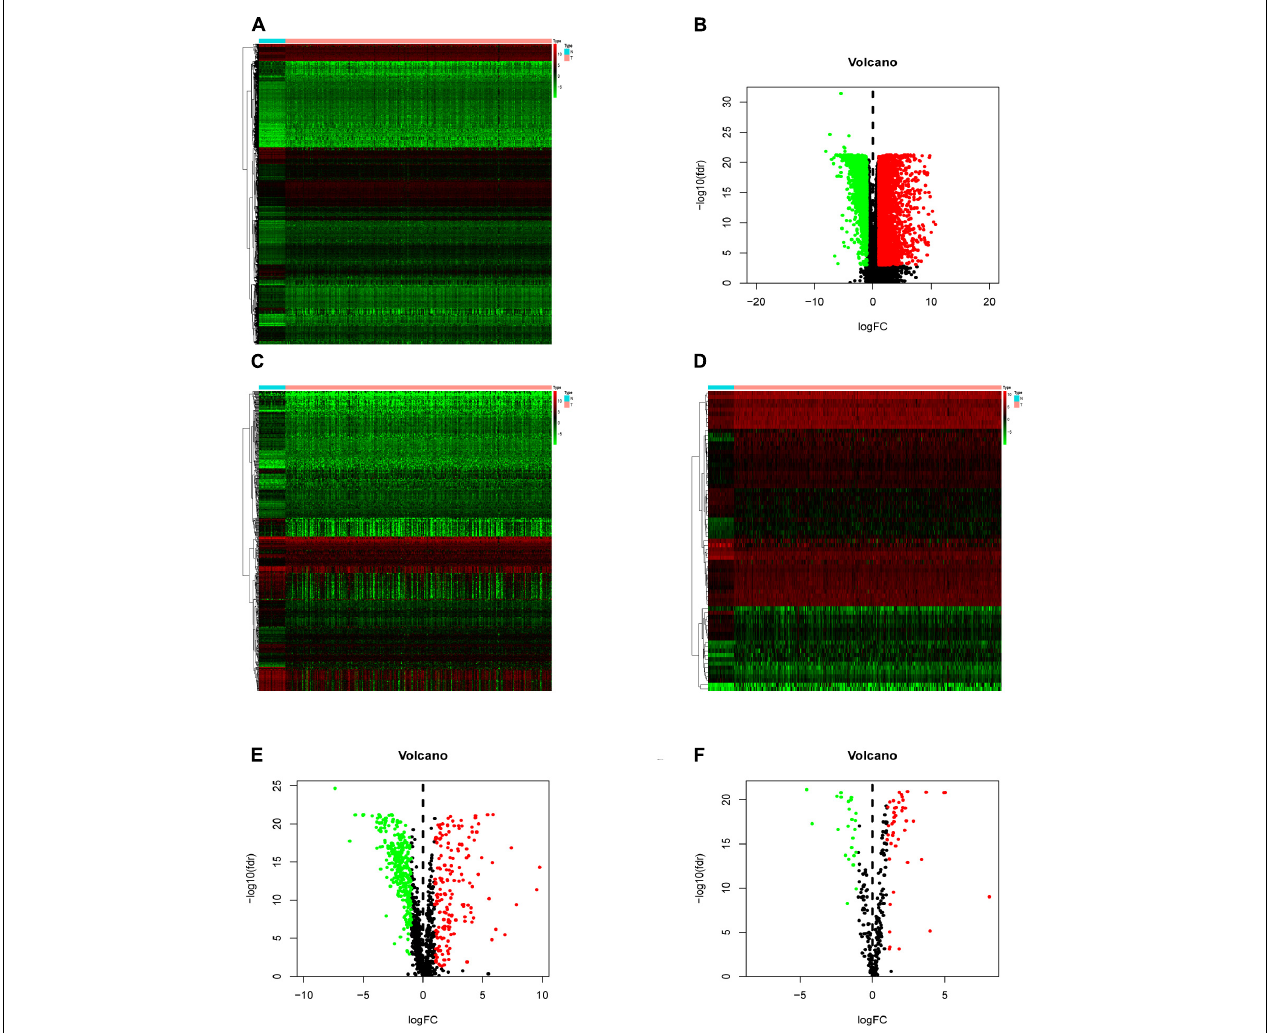
FIGURE 1 | Differentially expressed immune-related genes (IRGs) and cancer-related transcription factors (CRTFs) in colorectal cancer (CRC). (A) Heatmap of differentially expressed genes in CRC. The color from green to red represents the progression from low expression to high expression. (B) Volcano plot of differentially expressed genes in CRC. The red dots in the plot represent upregulated genes, and green dots represent downregulated genes with statistical significance. Black dots represent no differentially expressed genes in CRC. (C) Heatmap of significantly differentially expressed IRGs in CRC. (D) Heatmap of significantly differentially expressed cancer-related transcription factors in CRC. The color from green to red represents the progression from low expression to high expression. (E) Volcano plot of differentially expressed IRGs. (F) Volcano plot of differentially expressed cancer-related transcription factors.